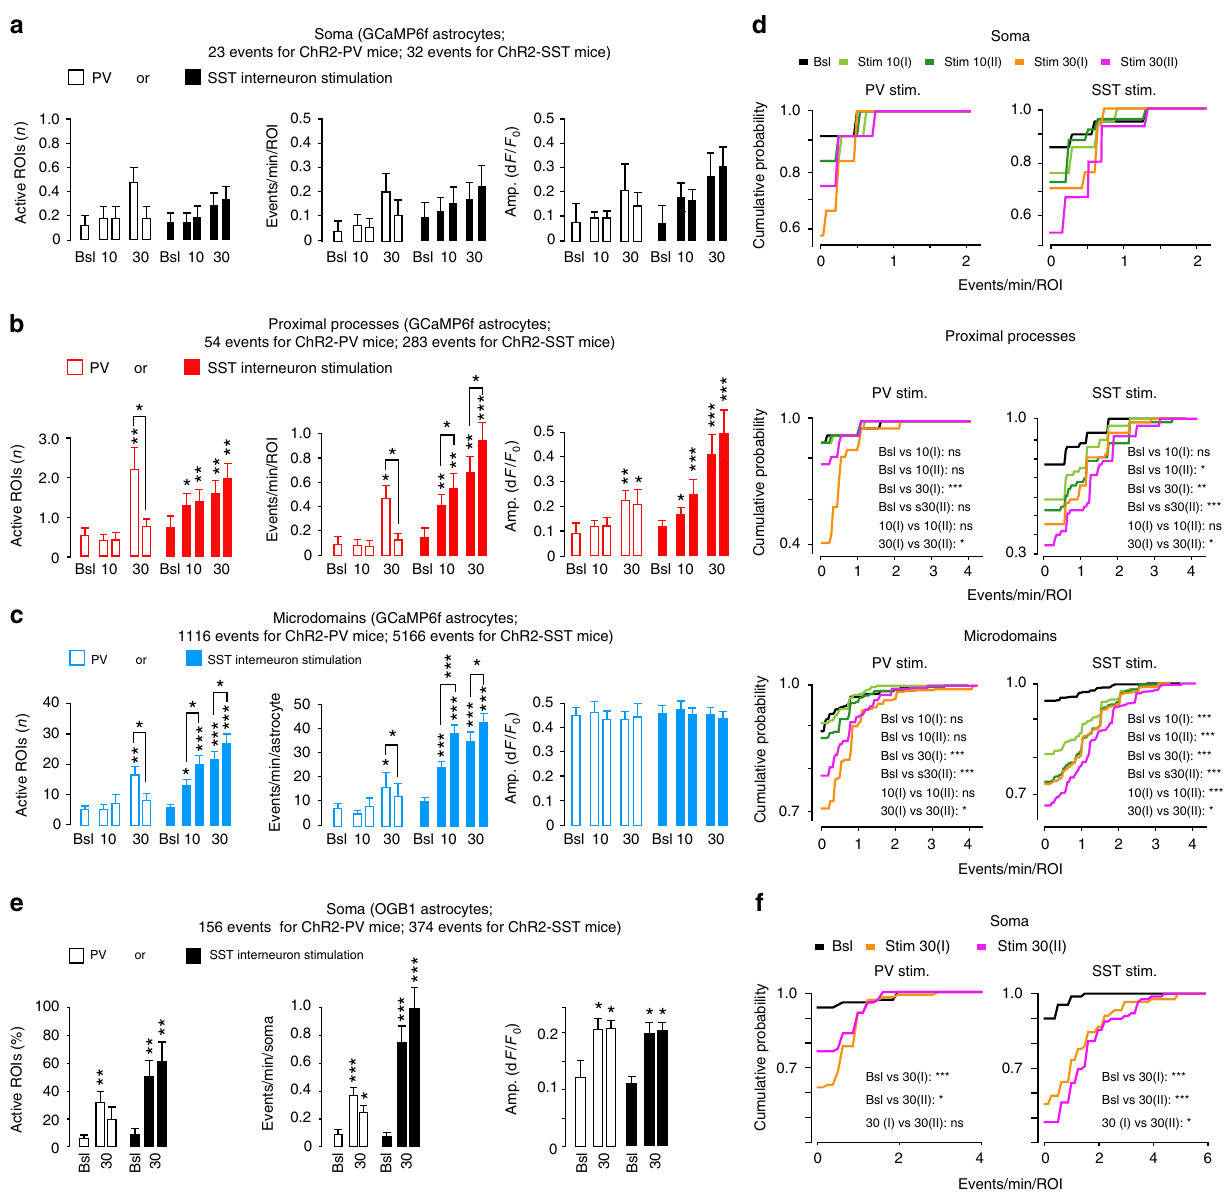
Fig. 2 Properties of the astrocyte response to PV and SST interneurons in vivo. a – c Average data of Ca 2+ signal dynamics at different compartments of GCaMP6f-astrocytes from ChR2-PV- or ChR2-SST-GCaMP6f mice in response to PV interneuron (14 astrocytes, 7 mice) and SST interneuron signaling (20 astrocytes, 8 mice). d , f Cumulative distributions of astrocytic Ca 2+ events con fi rming signi fi cant response depression to successive PV interneuron stimulations and signi fi cant response potentiation to successive SST interneuron stimulations. * p ≤ 0.05, ** p ≤ 0.01; *** p ≤ 0.001, Kolmogorov – Smirnov test. Exact p- values for the data reported in this as well as all the other fi gures are reported in the Supplementary Table 4e. Mean percentage of responsive astrocytes, mean frequency and amplitude of somatic Ca 2+ events in response to PV interneuron (white bars, 100 astrocytes, 6 ChR2-PV mice) or SST interneuron (black bars, 90 astrocytes, 7 ChR2-SST mice) optogenetic activation in the SSCx in vivo after loading with OGB-1 and the speci fi c astrocytic marker SR101. Data are represented as mean ±